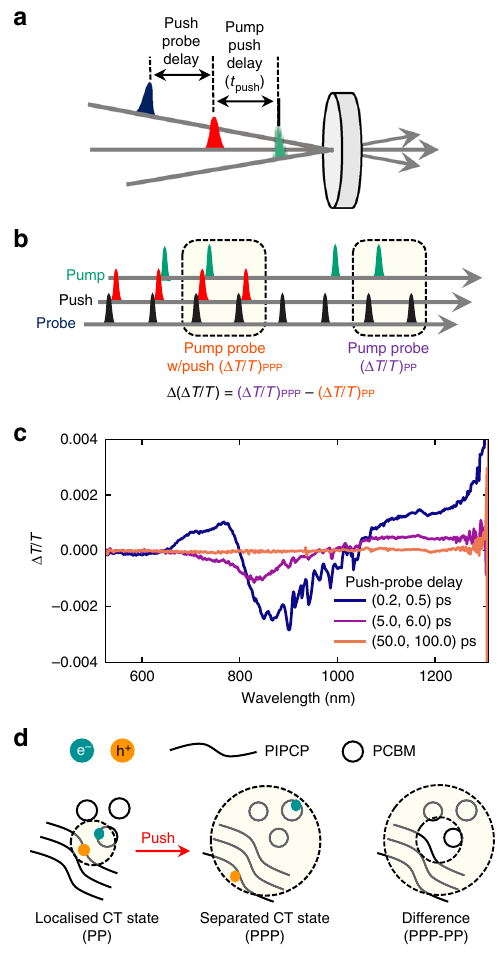
Fig. 3 Pump-push-probe isolates electroabsorption. a Schematic for the time relationship between the pump, push and probe pulses. b Pulse sequence used to record the TA ( Δ T / T ) with and without the push pulse where their difference is the push-induced change in TA ( Δ ( Δ T / T )). c Push-induced changes in TA spectra for a pump-push ( t push ) delay of 1.2 ps at various push-probe delays at a pump fl uence of 50 μ J cm − 2 and push fl uence of 90 μ J cm − 2 . d Schematic describing how the push pulse interacts with the localised CT states resulting in a more separated CT state. The shaded region re fl ects the region affected by the dipolar electric fi eld generated from the electron-hole pair. Differential, push-induced TA re fl ects the additional electroabsorption generated by the push pulse where larger signals correspond to more initially localised CT